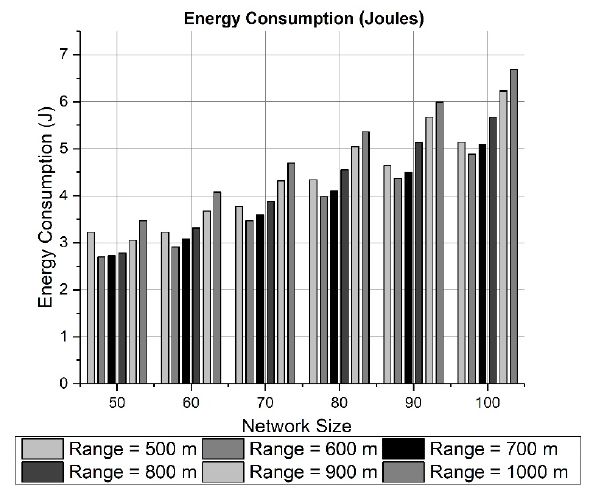
Figure 12. Total energy consumption in 50 Rounds (2000 × 2000 × 500 m).